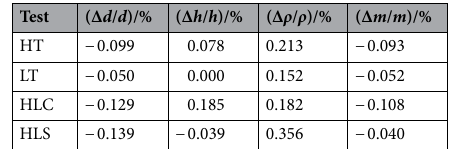
Table 1. Variation ratios of mass and size of the HNIW/FOX-7 based PBX